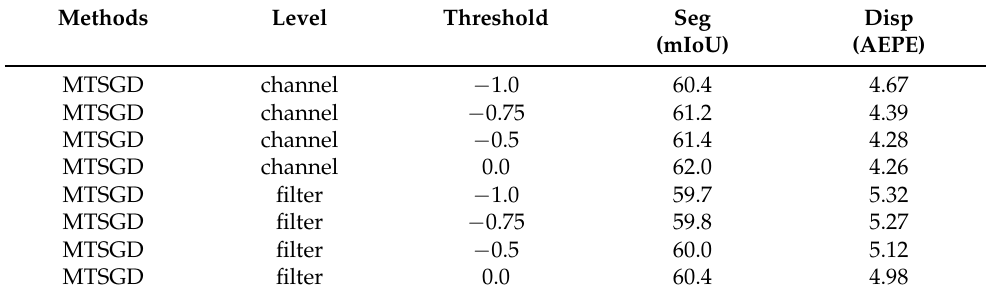
Table 4. Investigation of the level of direction vector for MTSGD. The ’channel’ denotes the direction vector that is calculated based on each channel of the convolutional kernel of each convolution kernel. In addition, ’filter’ denotes that the direction vector is calculated based on the whole parameter Methods